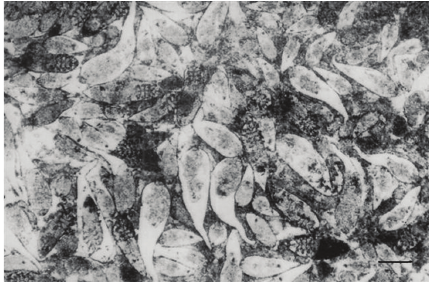
Figure 4: Numerous Demodex bovis mites and its different develop- mental stages, pus, and cell debris in a crushed specimen of infected purulent material extracted from skin lesions of demodectic mange. Scale bar: 70 𝜇